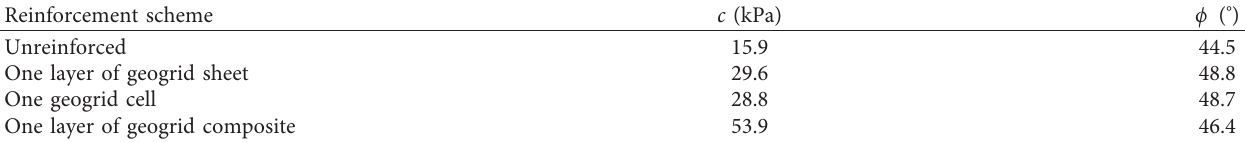
Two layers of geogrid